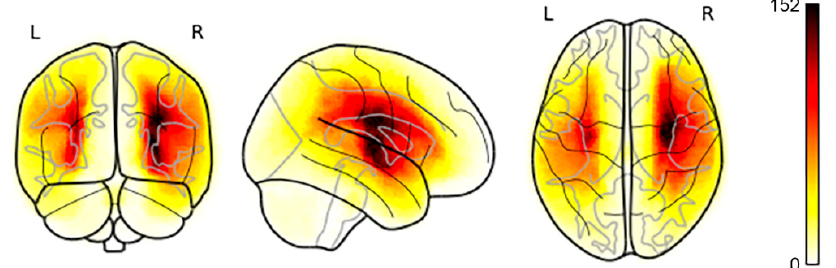
Figure 1. Lesion map across all subjects ( n = 655) visualized in the standard MNI template. Darker colors indicate a higher frequency of lesions at a given